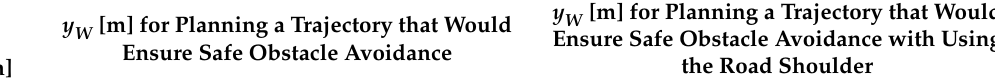
Table 3. Possibilities of safe avoidance of the obstacle.